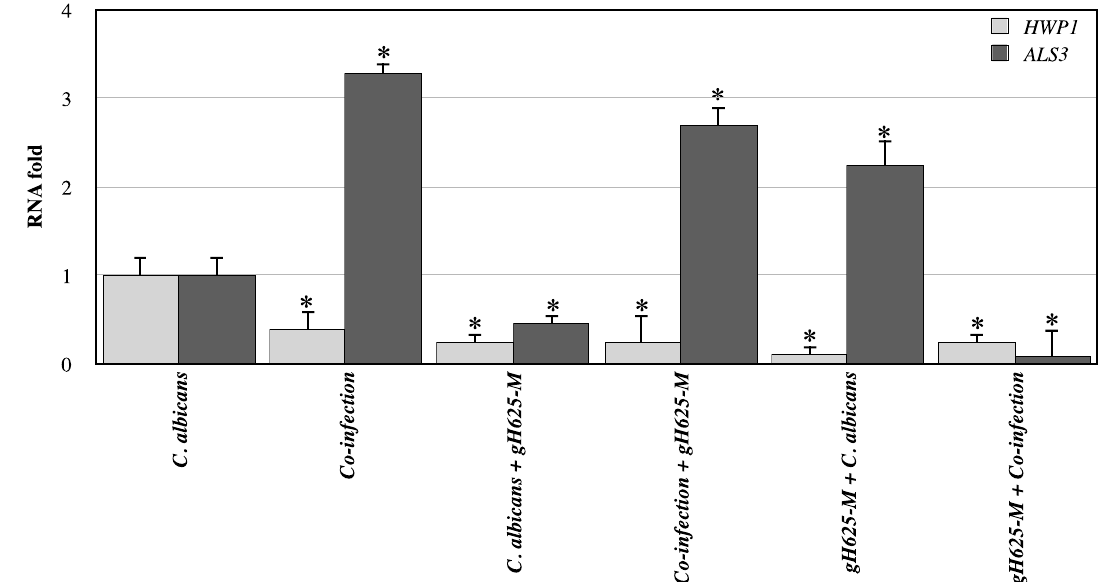
Figure 7. Relative mRNA expression levels of C. albicans virulence genes ( HWP1 and ALS3 ) in G. mellonella larvae at 24 h, measured using real-time PCR analysis and calculated by the 2 ( − ∆∆ C(T)) method. Actin gene was used as housekeeping. Each sample was tested and run in duplicate. No-template controls were included. * asterisk indicates that the difference vs. expression of larvae treated with C. albicans only is statistically significant (Wilcoxon two group test, p < 0.05). Error bars represent the SEM.